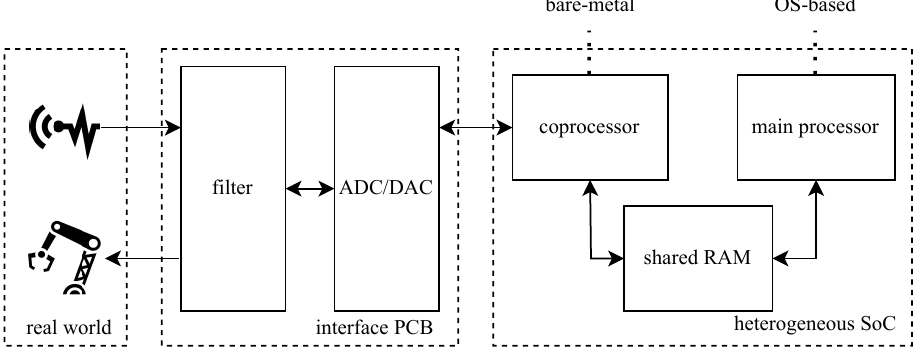
Figure 1. Necessary components for a functioning control system. A separate PCB has to be designed to combine the selected ADC and/or DAC (including appropriate filtering) with the controller. The controller will control the interface with the ADC and DAC according to the timing diagrams necessary for the ADC sampling and/or DAC actuation. This requires an exact timing specific to the chosen